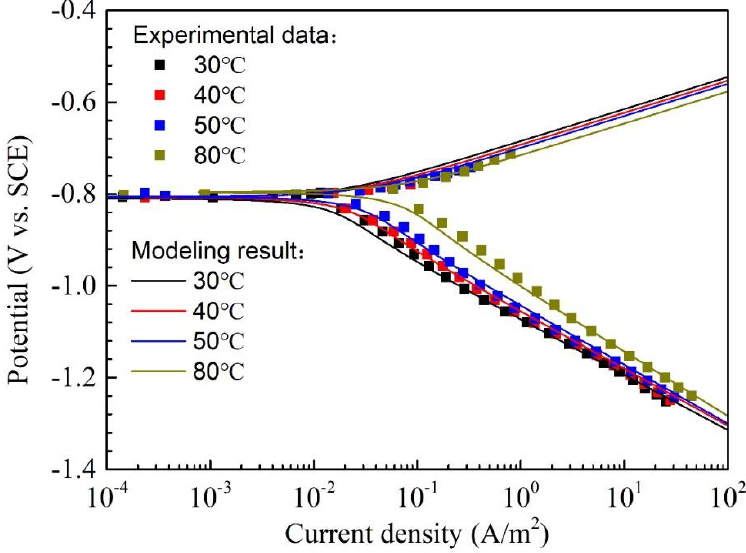
Figure 5. The polarization curves and modeling results of Q345R steel in 1 wt.% NaCl solution with 0.08 mg/L oxygen at pH 6.0 under different temperatures. Square: experimental data. Solid line: modeling result.